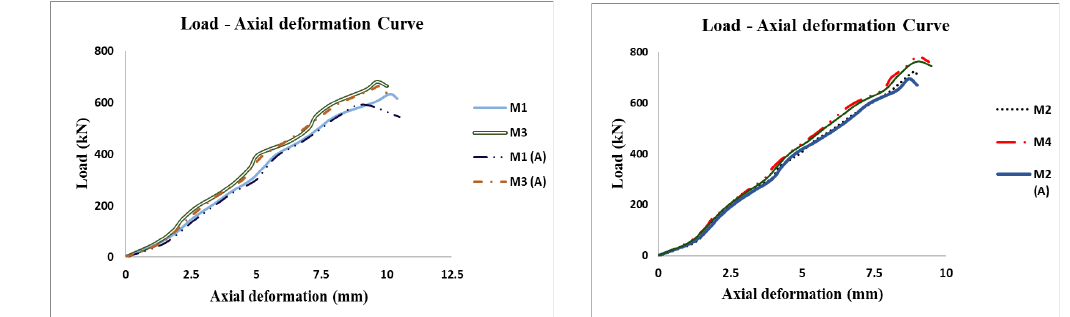
Figure 15. Load vs. axial deformation curves of self-stressed columns for the impact of D / t